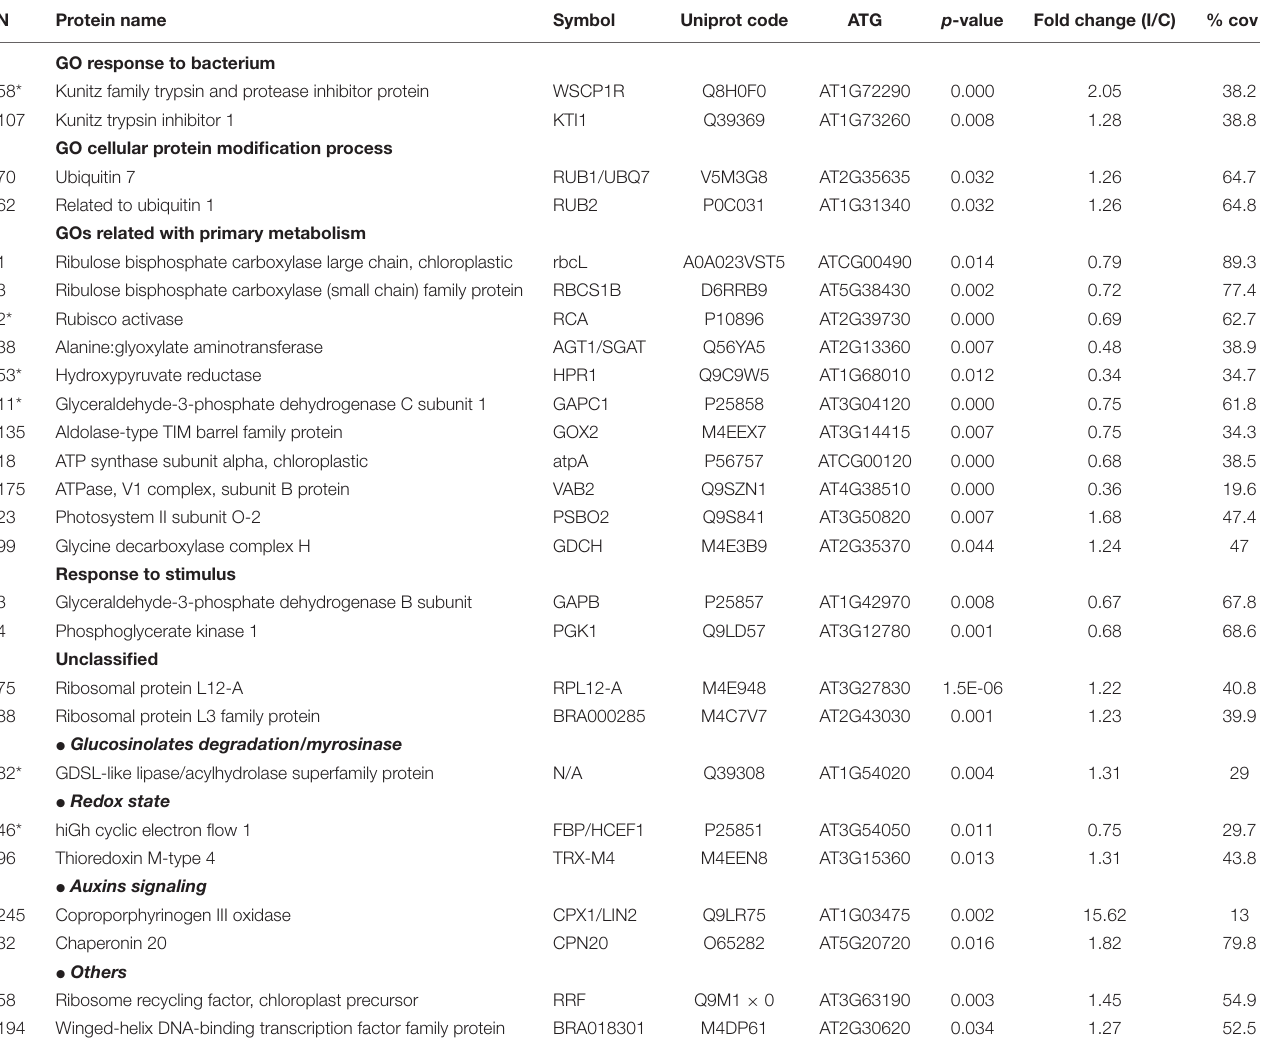
TABLE 1 | Proteins differentially induced 3 dpi. FC(I/C): the protein abundance ratio (inoculated/control);% cov: percentage of matching amino acids from identified peptides divided by the total number of amino acids in the